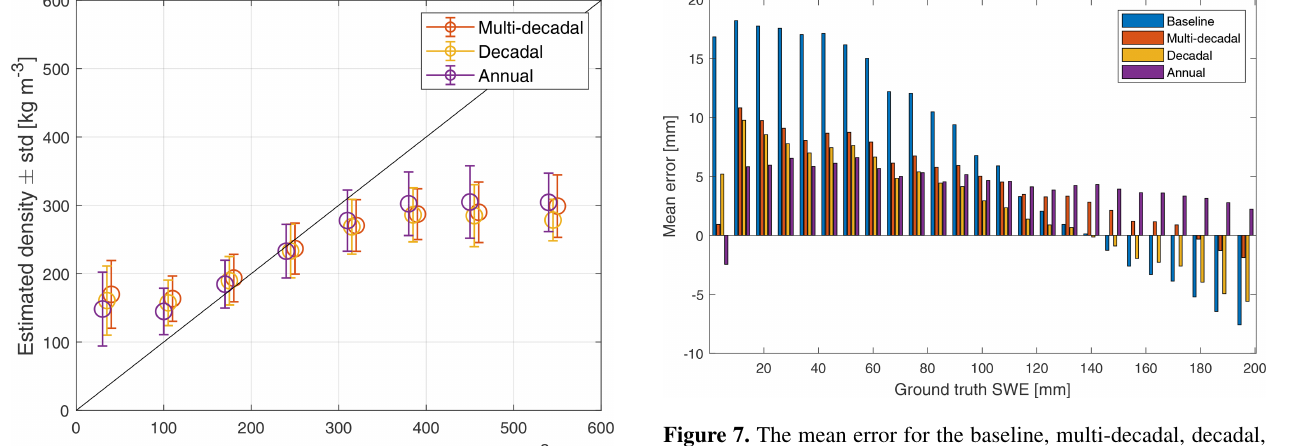
Figure 7. The mean error for the baseline, multi-decadal, decadal, and annual SWE estimates, 2000–2009